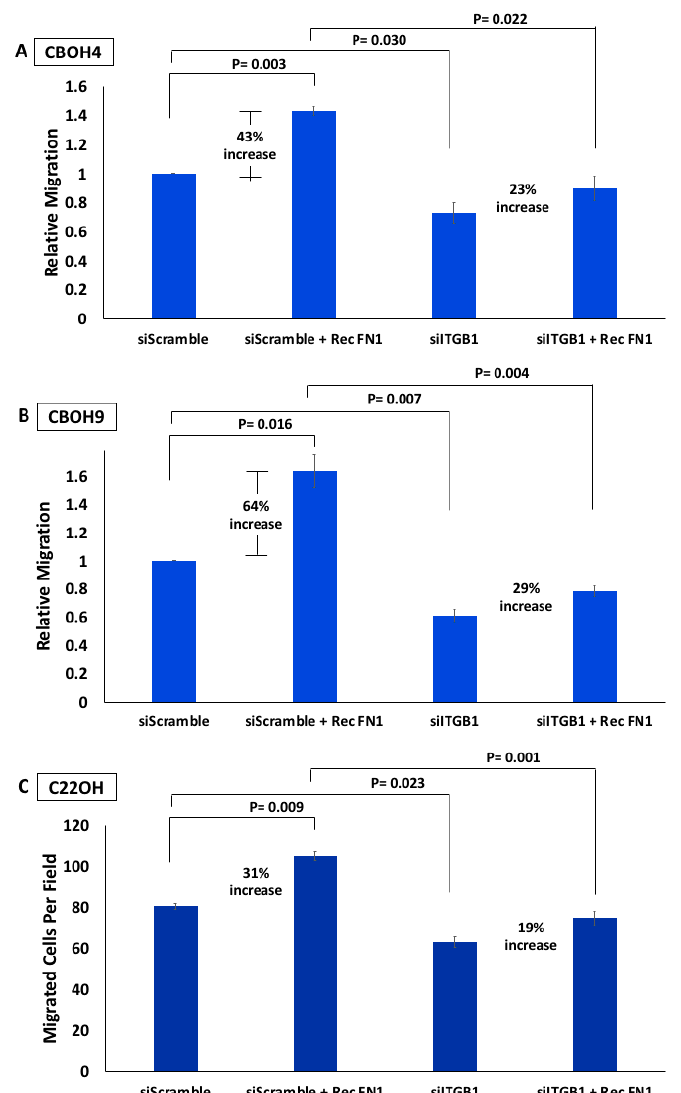
Figure 3. Recombinant FN1 is enough to induce greater CTC migration but not sufficient to completely rescue migration deficits when ITGB1 is knocked down. Recombinant FN1 was added to CTCs that were treated concurrently with either siScramble or siFibronectin. Migration was then assessed via wound healing assays performed on ( A ) CBOH4 and ( B ) CBOH9 CTCs, or transwell migration assays performed on ( C ) C22OH CTCs. Data provided on graphs are presented as mean ± standard error of the mean (SEM); n = 3. Statistical analysis was performed using t ‐ test, where p < 0.05 was deemed significant.